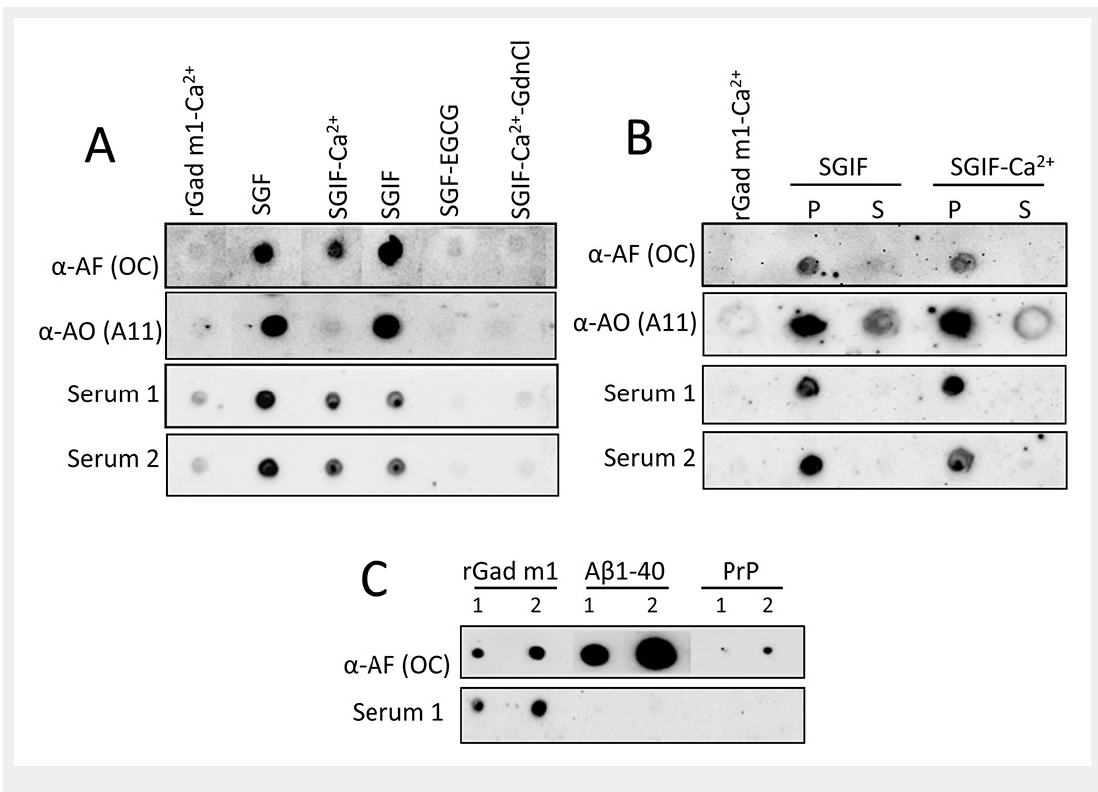
IgE from fish allergic patients sera recognises the rGad m 1 amyloid fibrils. (A) Dot-blot analysis of the immunoreactivity of rGad m 1 species probed with anti-amyloid fibrils (OC), anti-amyloid oligomer (A11) antibodies and with the sera from two fish-allergic patients indicate IgE binding to native amyloid fibrils. Dots correspond to 20 ng of fresh rGad m 1 solution in simulated intestinal fluid (SIF) containing 5 mM Ca 2+ , rGad m 1 fibrillated for 36 h in simulated gastric fluid (SGF) and then diluted 1/50 in SGF, SIF with 5 mM EDTA (SGIF), SIF with 5 mM CaCl 2 (SGIF-Ca 2+ ) and SIF with 5 mM CaCl 2 and 6 M GdnCl. SGF- epigallocatechin gallate (EGCG) corresponds to rGad m1 incubated in the presence of 20 μM EGCG for 36 h and then diluted 1/50 in SGF. ( B ) Separation of soluble (S) and pellet (P) fractions reveal that allergic patients IgE recognise insoluble amyloid fibrils. Fibrils formed at 140 μM protein concentration in SGF were diluted 1/50 in SIF either with 5 mM EDTA (SGIF) or 5 mM CaCl 2 (SGIF-Ca 2+ ) and centrifuged at 100,000xg for 1 h at 4 °C. ( C ) Anti-amyloid fibrils antibody (OC) reacts with amyloid assemblies of rGad m 1, Aβ1–40 and HaPrP 23–231, but IgE from allergic patients sera recognised specifically rGad m 1 fibrils. Labels 1 and 2 correspond to the load of 10 and 20 ng of protein,